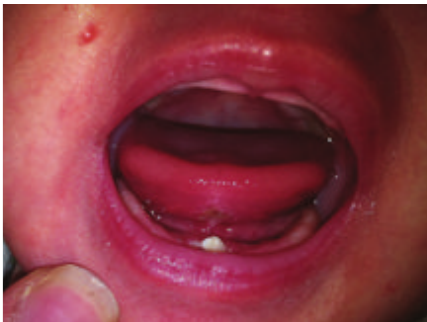
Figure 2: Left side natal tooth surgically removed.